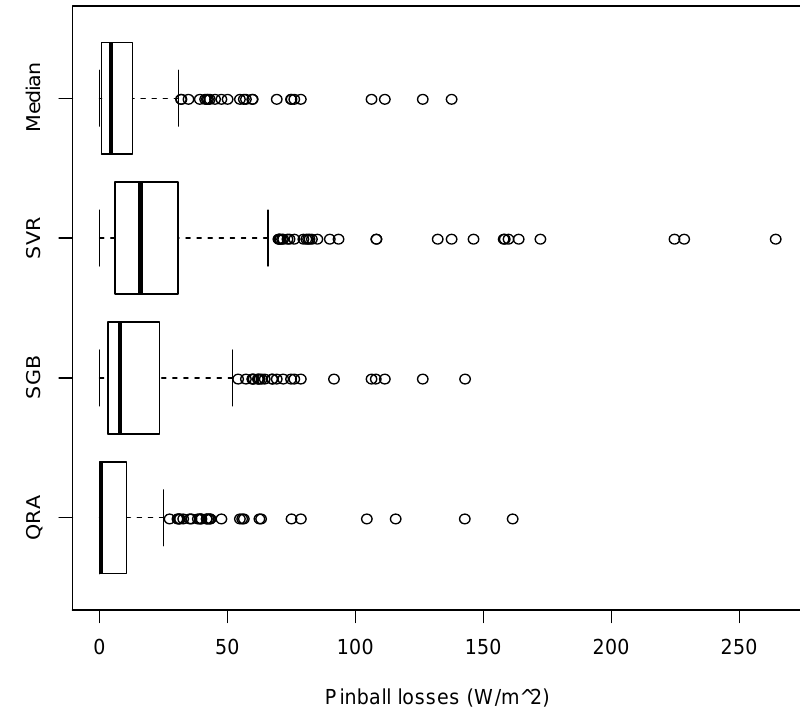
Figure 6. Top panel: Plot of pinball losses from the quantile regression averaging (QRA) and Median models in April 2010 (8–22 April 2010, 337 forecasts). Bottom panel: Box plots of pinball losses from the QRA, SGB, SVR and Median models in April 2010.